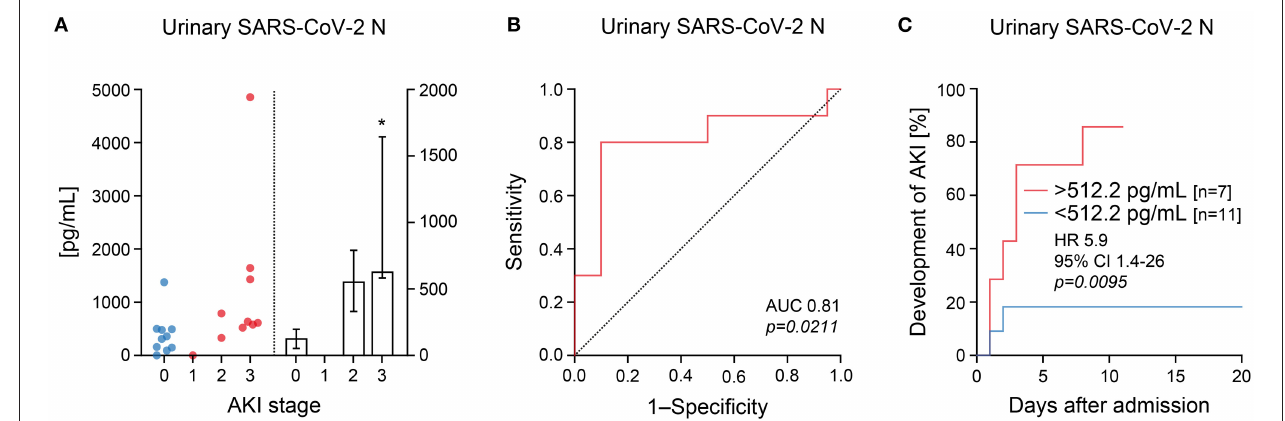
FIGURE 1 | Urinary SARS-CoV-2N levels at ICU admission associate with AKI in COVID-19. (A) Relation between the AKI stage (according to KDIGO) and urinary levels of SARS-CoV-2N is shown by scatter dot plots (plotted on the left Y-axis) and bar graphs reflecting median with IQR (plotted on the right Y-axis). (B) ROC analysis for urinary SARS-CoV-2N assessed at ICU admission for association with AKI in COVID-19. (C) Frequency and survival analysis for cumulative incidence of AKI after group separation for urinary SARS-CoV-2N at 512.2 pg/mL. AKI, acute kidney injury; AUC, area under the curve; CI, confidence interval; HR, hazard ratio; ICU, intensive care unit; ROC, receiver operator curve; SARS-CoV-2N, severe acute respiratory syndrome coronavirus 2 nucleocapsid protein.